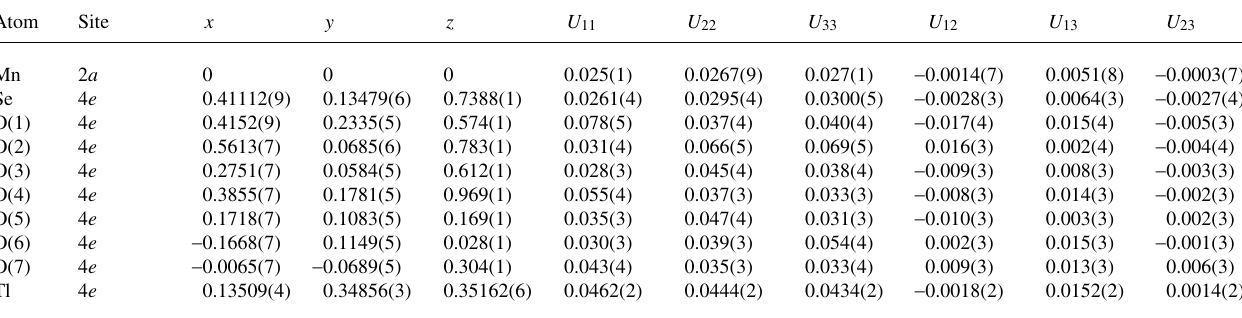
Table 6. Atomic coordinates and displacement parameters (in Å 2 ) .